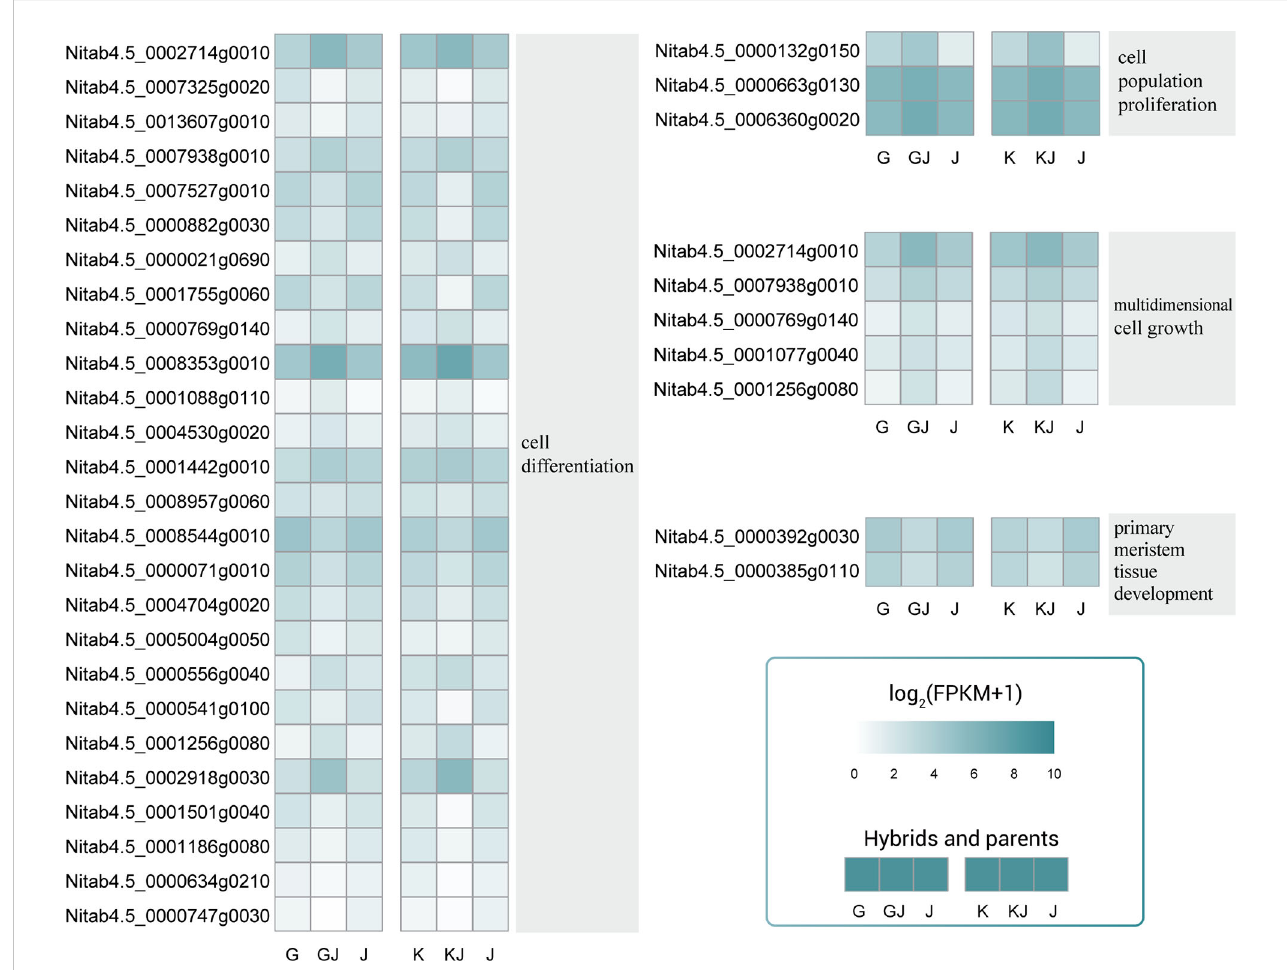
FIGURE 7 Overdominant expression genes related to cell population promotion, cell differentiation, multiple cell growth and primary commodity issue development. These genes were overdominant expression in both